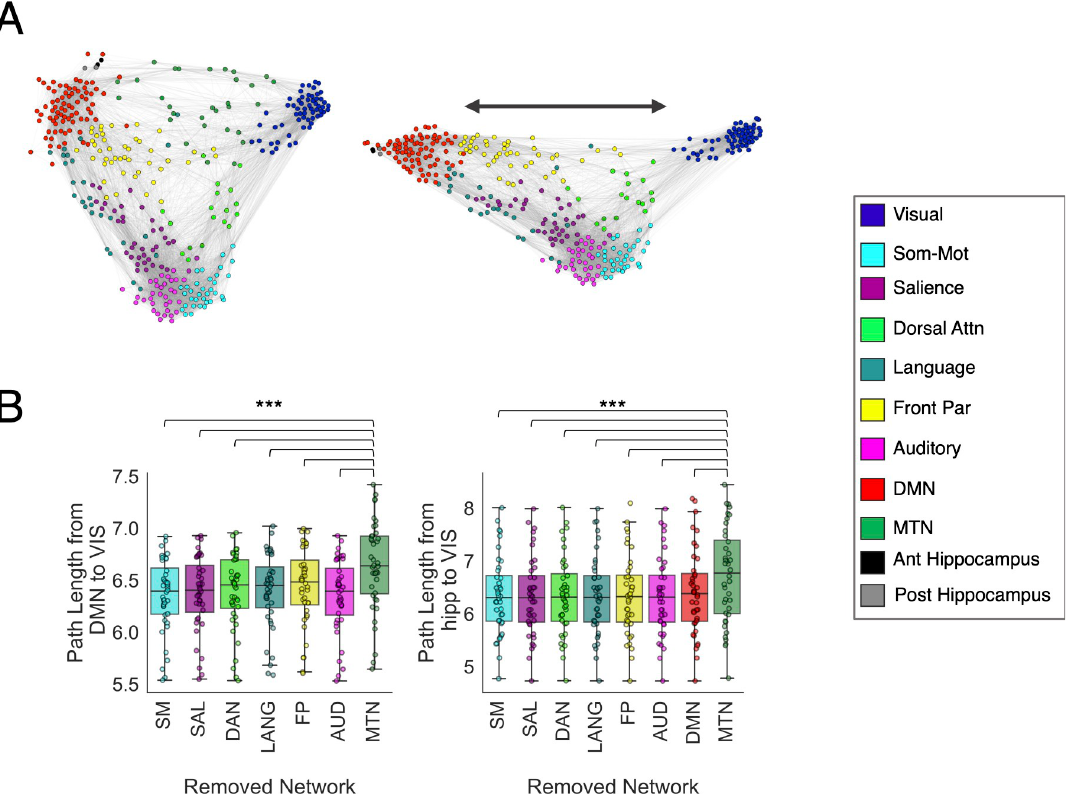
Fig 2. Removal of the MTN disproportionately decreases the network connectivity of the DMN and visual network. (A) Force- directed graph of the group-averaged networks color coded by community membership of the selected partition created using the ForceAtlas2 algorithm [54] with the MTN present (left) and with the MTN excluded (right). (B) Boxplots displaying the path length between the DMN and visual network or the path length between the hippocampi and visual network following removal of each network. ��� p < 0.001. Ant, anterior; A AU : AnabbreviationlisthasbeencompiledforthoseusedthroughoutFig 2 : Pleaseverifythatallentriesarecorrect : ttn, attention; AUD, auditory; DAN, dorsal attention network; DMN, default mode network; FP, frontoparietal; LANG, language; MTN, medial temporal network; Post, posterior; SAL, salience; SM, somatomotor; Som-Mot, somatomotor; VIS, visual. Data can be found at https://github.com/ajbarn/hippo_nets.